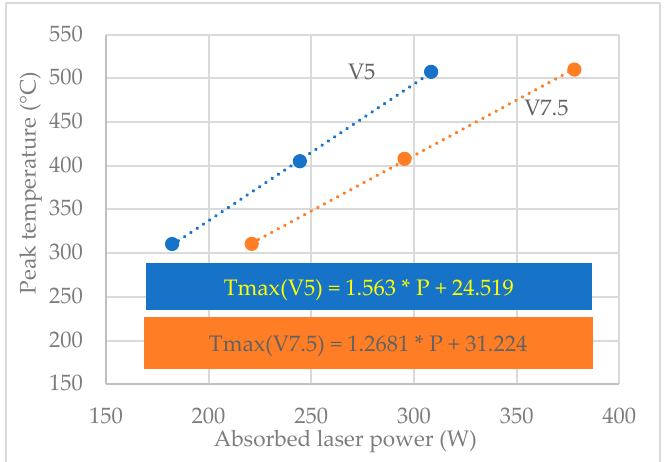
Figure 9. Absorbed laser power as a function of the peak temperature.